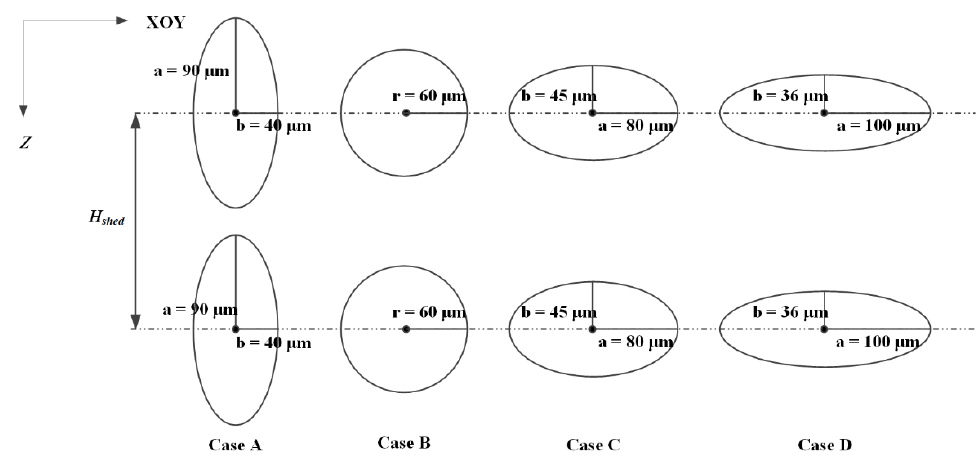
Figure 15. Representation of the cross section of the four vessel pairs ( α 0 = 30°).